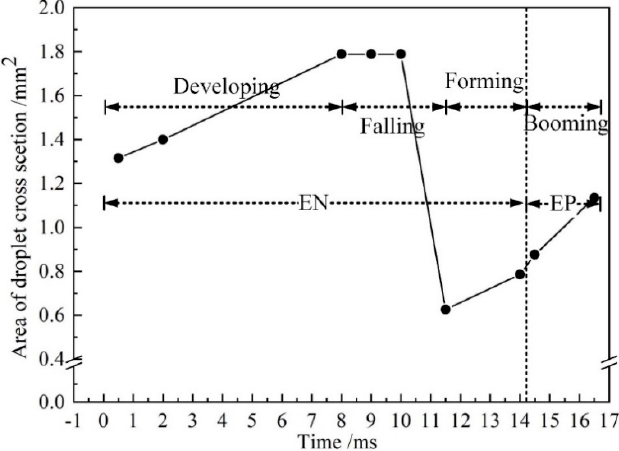
Figure 6. The evolution of the cross-sectional area of the droplet.